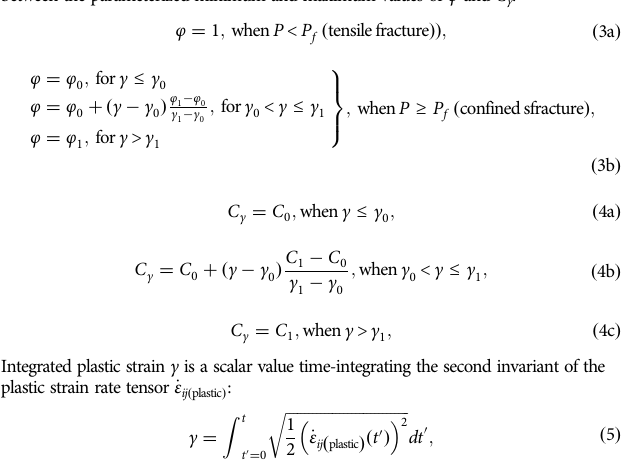
of the experimental data. The results of the recovery of several synthetic models are presented in Supplementary Materials.